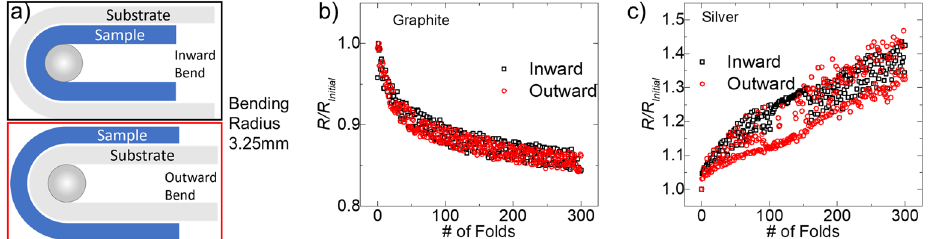
Fig. 4 Bending stress test of sprayable conductors on paper. a Schematic of the inward (black outline) and outward (red outline) bending about a radius of 3.25 mm. Bending results of b graphite and c silver for both inward (black, square) and outward (red, circle)